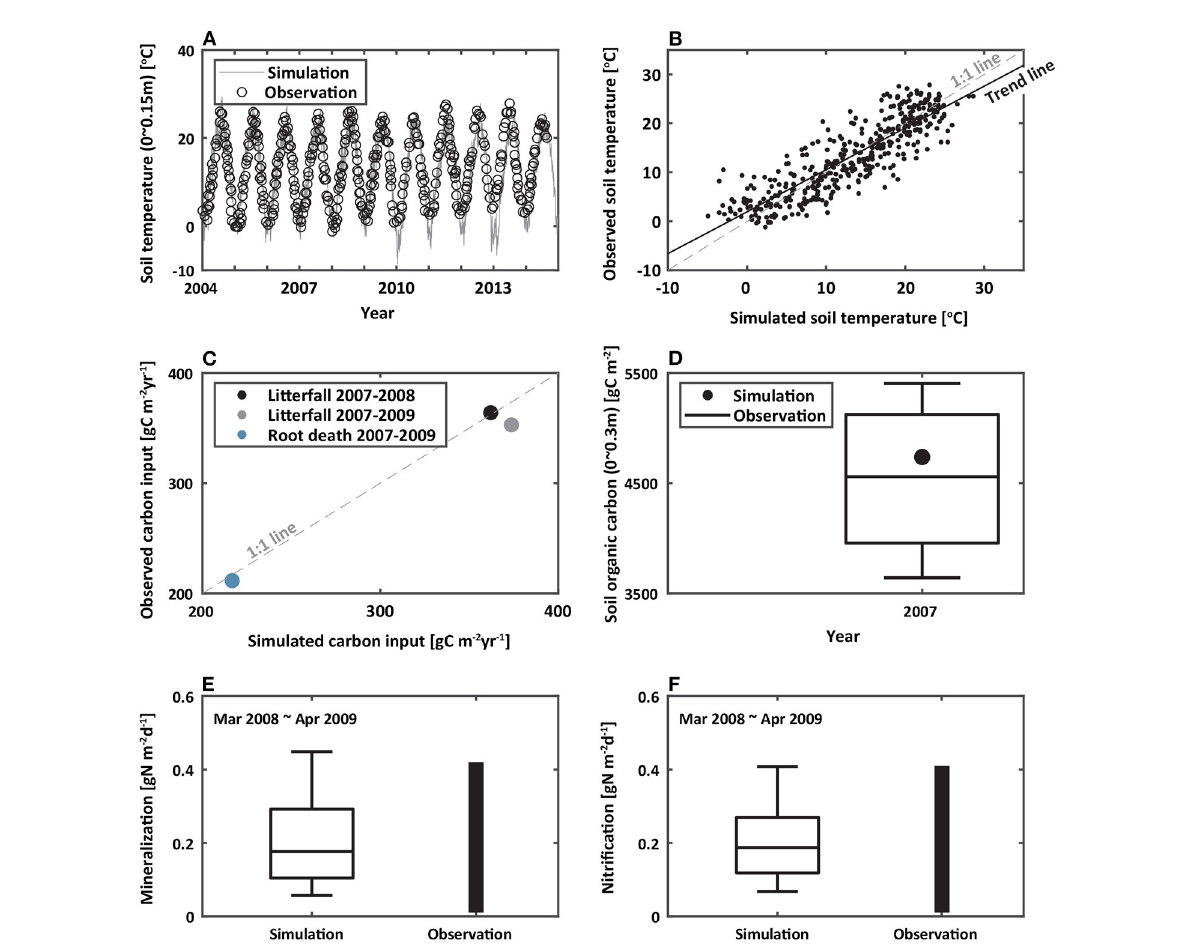
FIGURE3 Comparisons of modeled and observed (A,B) soil temperature to a depth of 0.15 m from 2004 to 2015 (Yun and Chun, 2018), (C) carbon inputs from 2007 to 2009 (Lee et al., 2009; Noh et al., 2017), (D) soil organic carbon to a depth of 0.3 m in 2007 (Lee et al., 2009), and (E) mineralization and (F) nitrification to a depth of 0.15 m from 2008 to 2009 (Yoon et al., 2015). The black line in (B) represents the trend line. Gray dashed lines in (B,C) represent a 1:1 relationship. The boxplot in (D) shows the distribution of observed soil organic carbon. The bar plots in (E,F) represent the observed ranges of mineralization and nitrification,